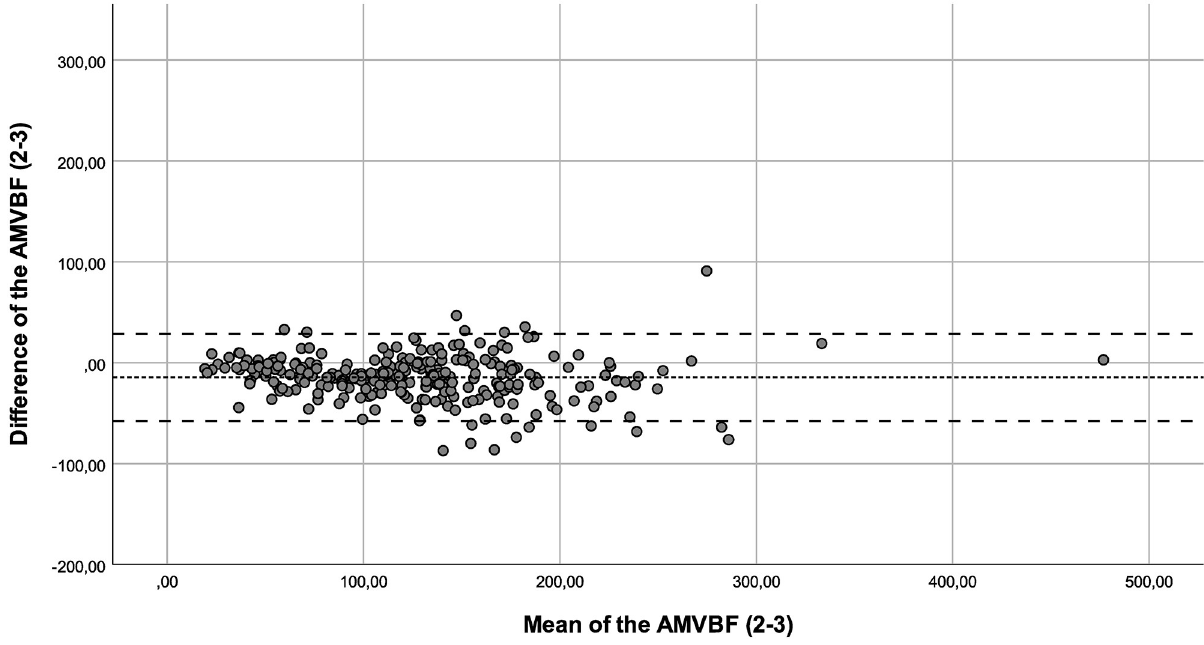
Fig 2. Bland-Altman plot for the difference between test and retest (test 2–3) of the anterior maximum voluntary bite force (AMVBF) for patients with JIA. The dashed line represents the mean difference between test and retest, and the striped lines represent the 95% limits of agreement.